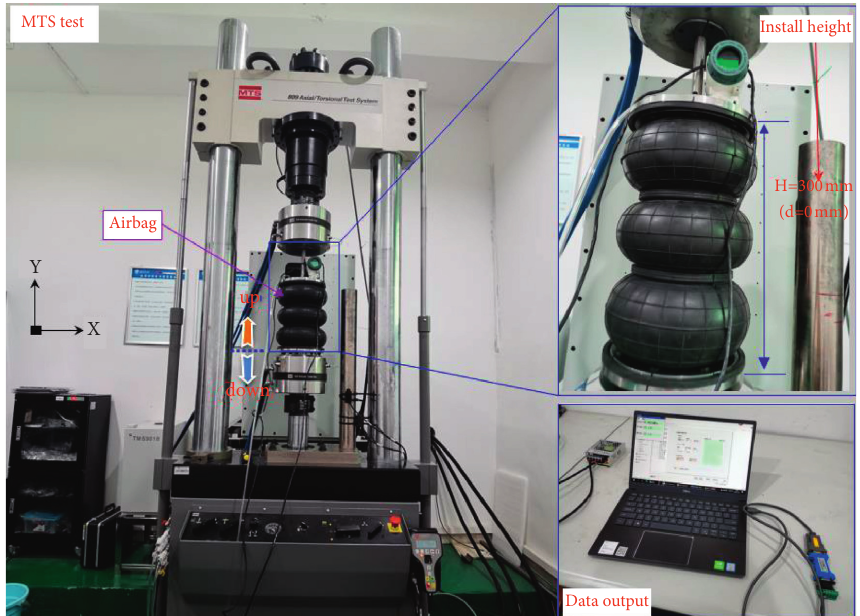
Figure 2: Tension and compression tests of the airbag.